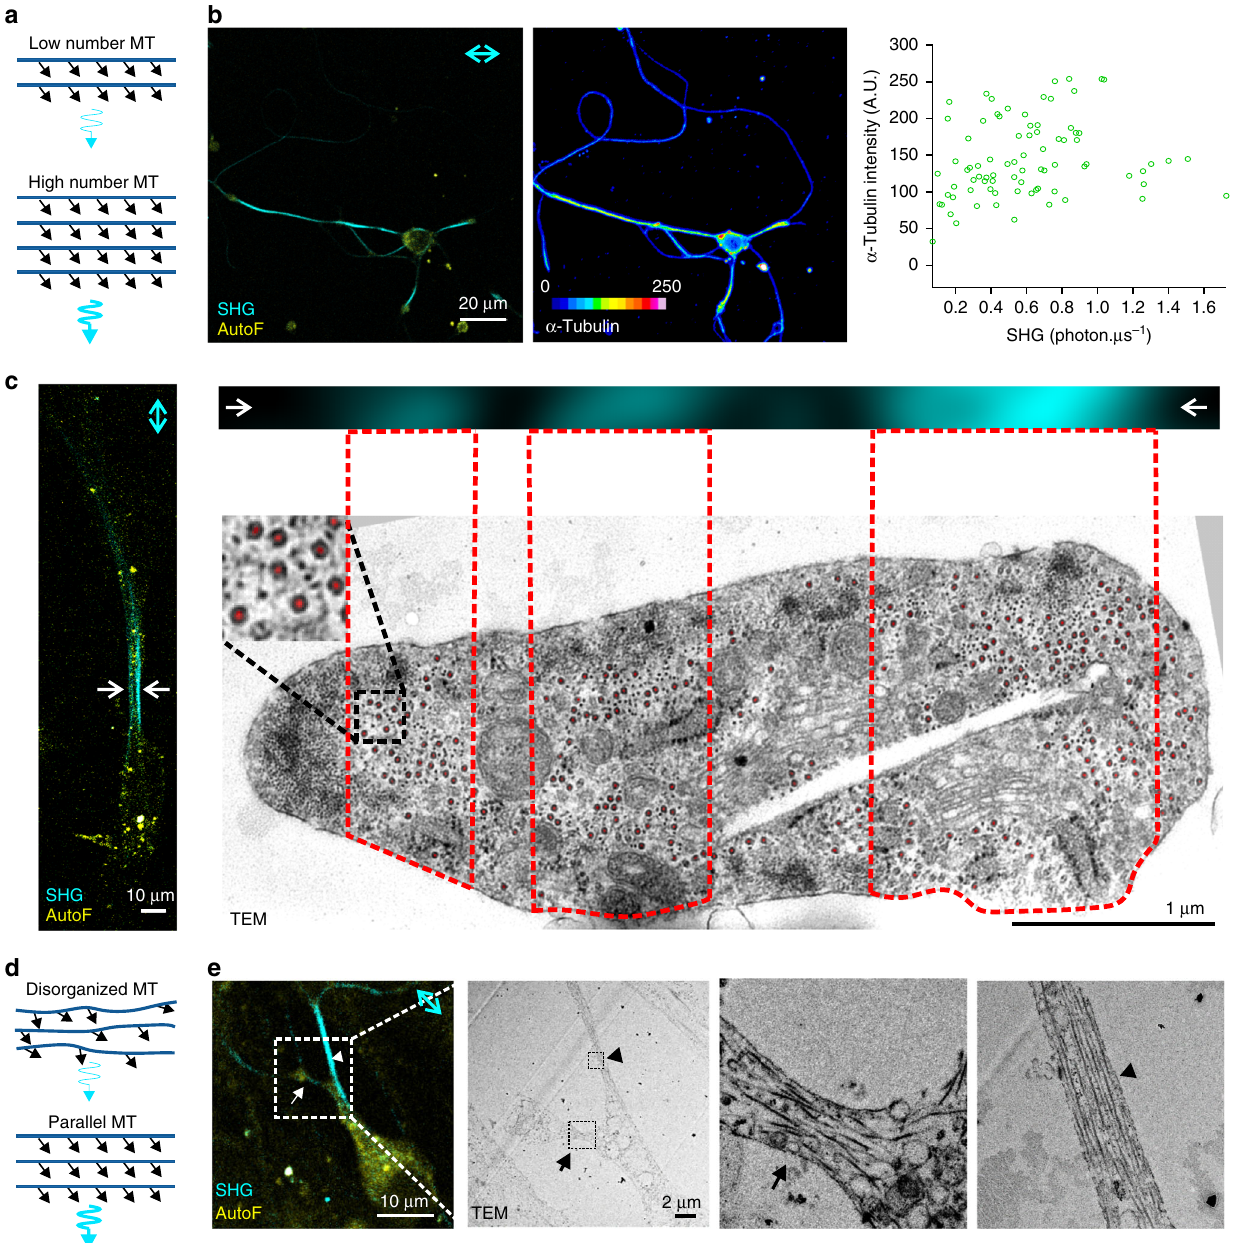
Fig. 3 Microtubule number and organization in fl uence SH signal intensity. a A low number of microtubules will generate SH signals with lower intensities as compared to a high number of microtubules and thus SH emitters. b SH signals correlated with α -tubulin staining intensities as a measure for the amount of microtubules present in the fi ber ( n = 81 cells from three independent experiments; p < 0.01 Spearman r = 0.2979). c SHG from three parallel regions in a fi broblast protrusion (arrows in fi broblast overview image (left)) indicate the region enlarged in the image at the top) correlated with a transmission electron micrograph of a cross section to visualize individual microtubules (red dots). Dotted line boxes in the micrograph represent the regions generating SH in the protrusion. d In a disorganized microtubule network, the resulting induced dipoles will be less aligned leading to a lower SH signal compared to a network that has more parallel-organized microtubules. e A cell with two processes, one that generates low (arrow) and one high (arrowhead) intensity SH signals (left) and its matched correlated transmission electron micrographs (TEM, right) to visualize microtubule organization at the ultrastructural level. The low- and high-intensity SH fi bers correspond to a disorganized (arrow) and parallel-organized (arrowhead) microtubule network respectively. Neuronal cultures were imaged at 7 DIV. All source data are provided as a Source Data fi (PFA) and ethylene glycol bis succinimidyl succinate (EGS). We found that all fi xatives, apart from EGS, lead to disappearance of the microtubule generated SH signal (Fig. 4a). It is well-known that fi xation causes conformational changes in proteins, even to conformation that is abolished by other fi xatives. Using an anti- an extent that explains binding af fi nities of antibodies as their body that speci fi cally recognizes GTP-bound tubulin dimers epitope can be altered during the fi xation process 28 . A change in